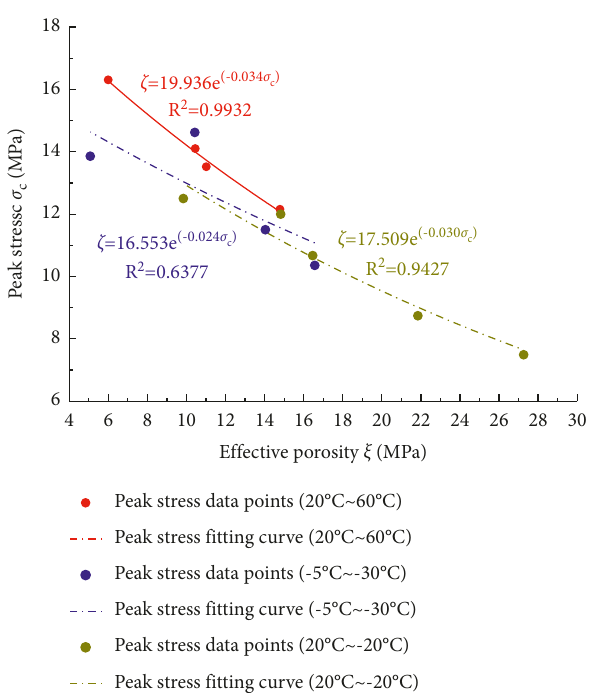
Figure 12: Relationship between pore efficiency and peak stress at different temperature